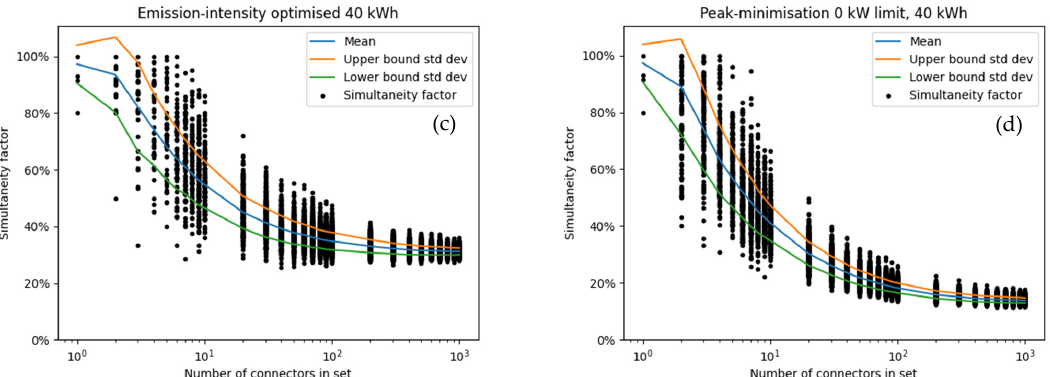
Figure A5. Coincidence factor assuming 40 kWh per CE for ( a ) naive charging; ( b ) price-optimised charging; ( c ) CO 2 intensity optimised charging; ( d ) peak power optimised charging. Note that peak power was optimised for all C simultaneously. Optimizing for each set in ( d ) for a low simultaneity factor likely results in significantly lower values. For the larger sets, the difference is minor. The blue line shows the mean across the randomly selected sets, and the orange and green lines the upper and lower boundaries of the standard deviation. Each randomly selected set was of the size shown on the x -axis.